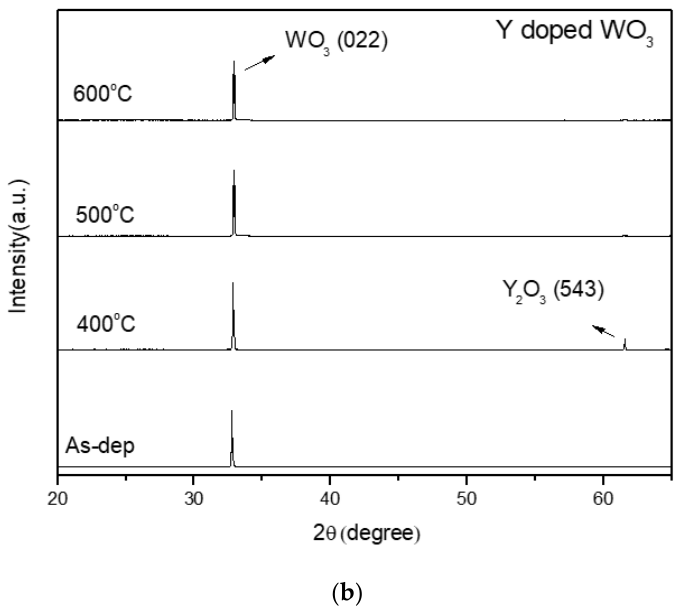
Figure 2. ( a ) XRD of the WO 3 film after annealing at various temperatures in O 2 ambient for 30 s. ( b ) XRD of the Y-doped WO 3 film after annealing at different temperatures in O 2 ambient for 30 s.